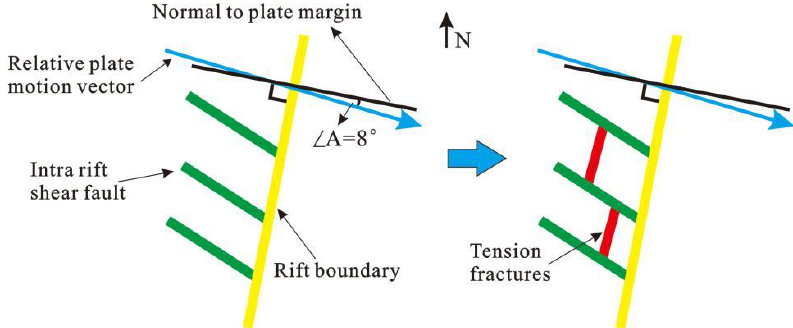
Figure 17. Inversion model of the bedrock fractures in the Kenya Rift Valley.